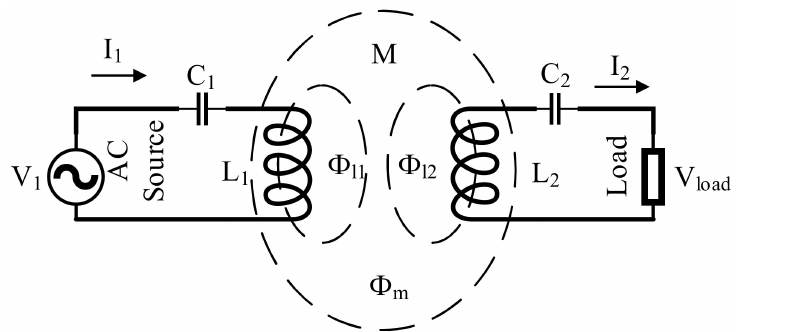
Figure 3. Classification of WPT.